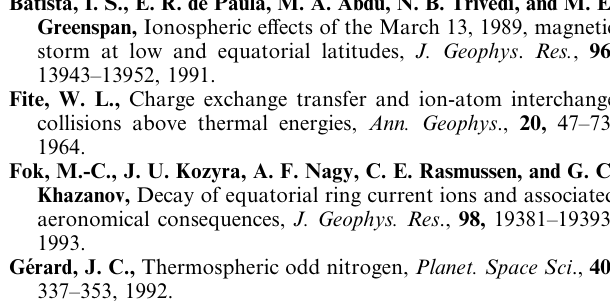
Fig. 8. Electron density profiles calculated for February 9, 1986 for a location close to Arecibo, again with (disturbed) and without (quiet) the ring current ionization source. Here, the model ring current was injected at 21:00 LT, and the electron density profiles were obtained 1/2 hour later at